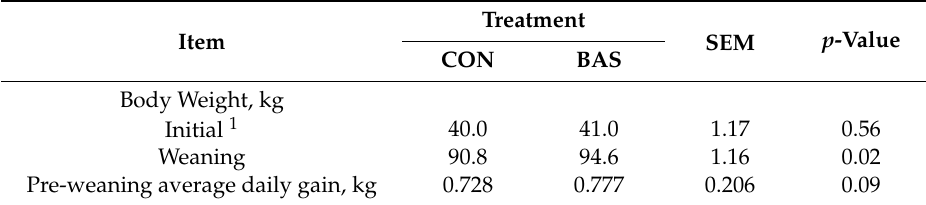
Table 1. Performance of female Gir × Holstein dairy calves receiving or not receiving (CON; n = 70) bovine appeasing substance (BAS; n = 70) during